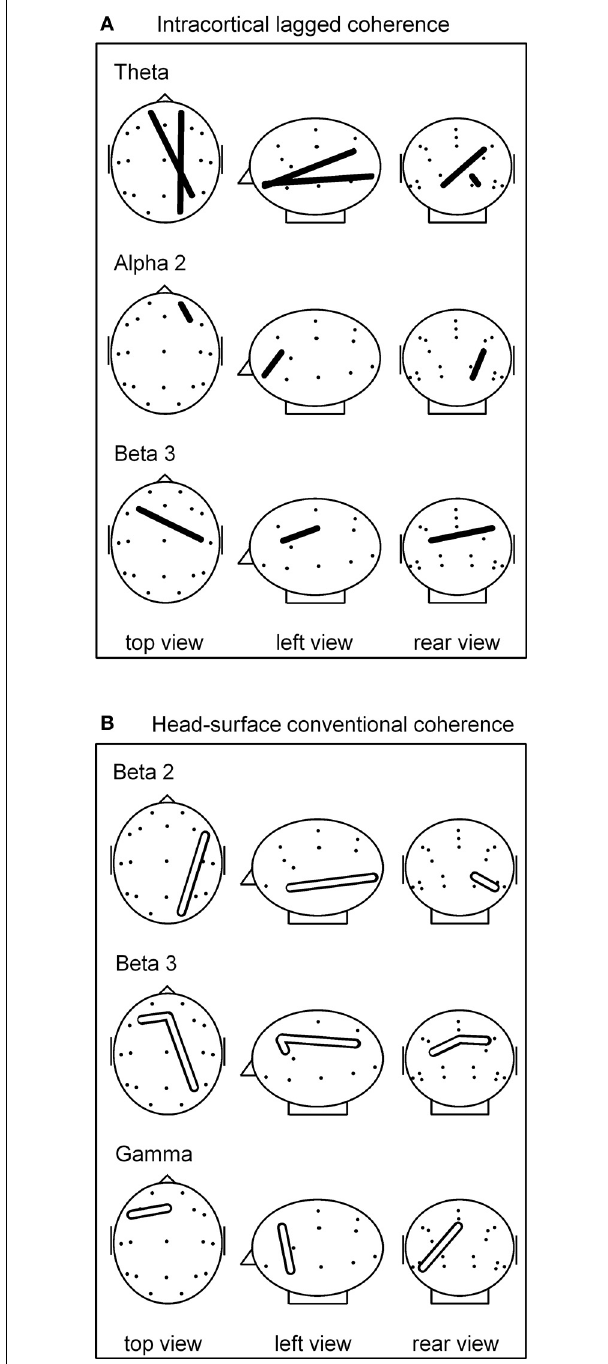
FIGURE 1 | (A) sLORETA-based intracortical lagged coherences that differed during breath counting compared to resting at p (corrected) < 0.05. All four connectivities were lower during breath counting. (B) Head-surface conventional coherences that differed during breath counting compared to resting at p (corrected) < 0.05. All four connectivities were higher during breath counting. Glass brain axial, sagittal, and coronal views, left ear left; ROI locations are indicated by dots. For ease of visualization, the intracortical ROIs are represented by the corresponding head-surface locations of the standard 19 electrode positions of the international 10–20 system.